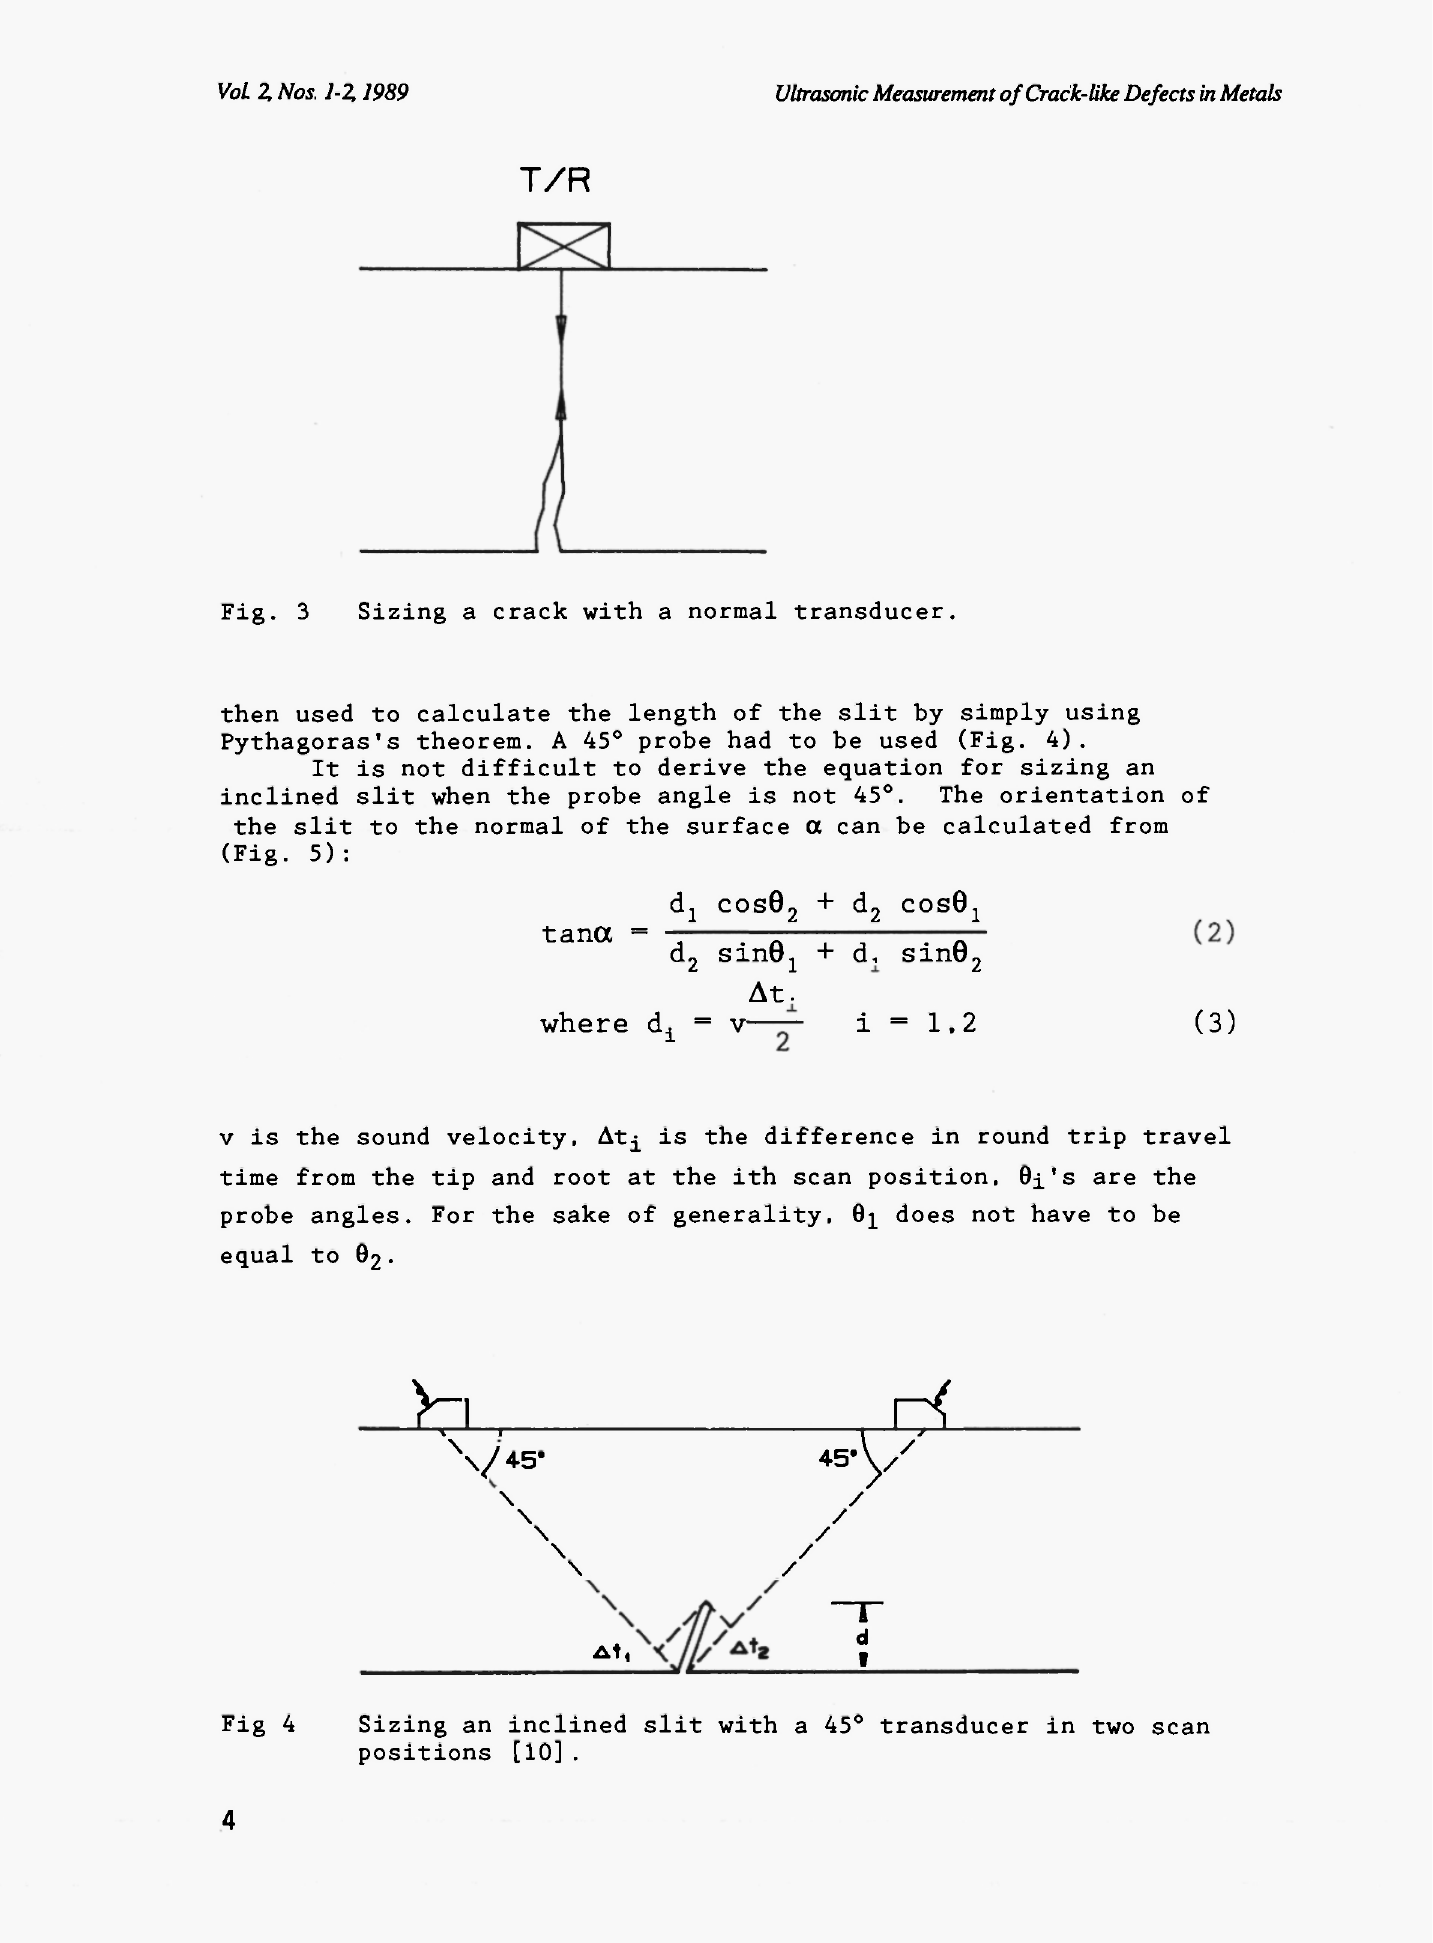
Fig 4 Sizing an inclined slit with a 45° transducer in two scan positions [10]